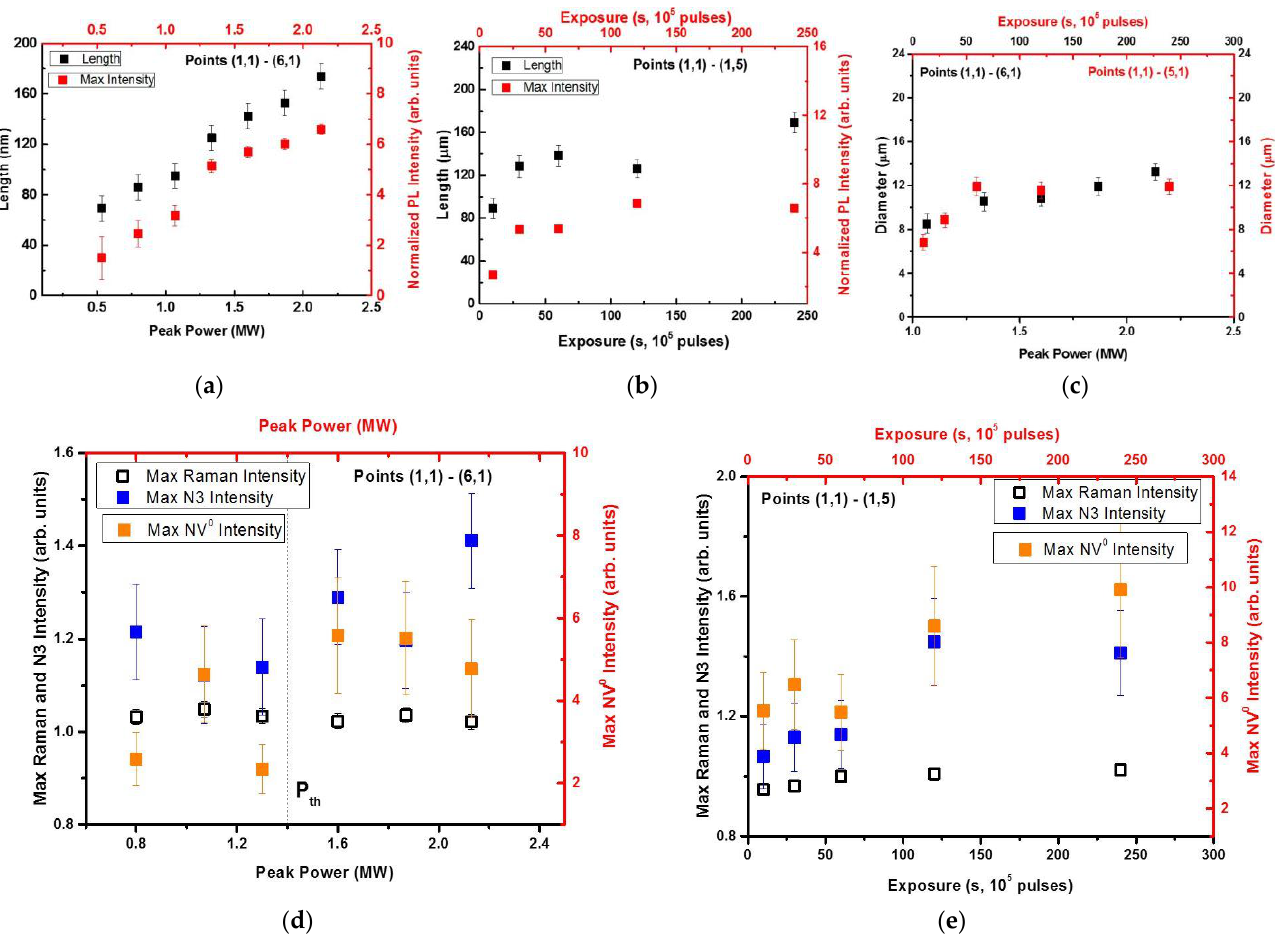
Figure 4. ( a ) Micromark length (dark symbols, left axis) and normalized maximal intensity of the peak at 550 nm wavelength (red symbols, right axis) versus peak power at 240 s exposure time (24 × 10 6 pulses). ( b ) Micromark length (dark symbols, left axis) and normalized maximal intensity of the peak at 550 nm wavelength (red symbols, right axis) versus exposure time at 2.1 MW peak power (fluence — 5.5 J/cm 2 , intensity — 18 TW/cm 2 ). ( c ) Micromark diameter (spot size) versus peak power at 240 s exposure time (dark symbols, left and bottom axes) and exposure time at 2.1 MW peak power (red symbols, right and top axes). ( d ) Micromark normalized maximal intensity at 428 nm (Raman signal, dark open squares) and 415 nm (N3 PL signal, blue squares) wavelength ( left and bottom axes), and at 575 nm (NV 0 PL signal, right and top axes) wavelength versus peak power at 240 s exposure time. ( e ) Micromark normalized maximal intensity at 428 nm (Raman signal, dark open squares) and 415 nm (N3 PL signal, blue squares) wavelength ( left and bottom axes), and at 575 nm (NV 0 PL signal, right and top axes) wavelength versus exposure time at 2.1 MW peak power. Low laser pulse power P < P th (<1.4